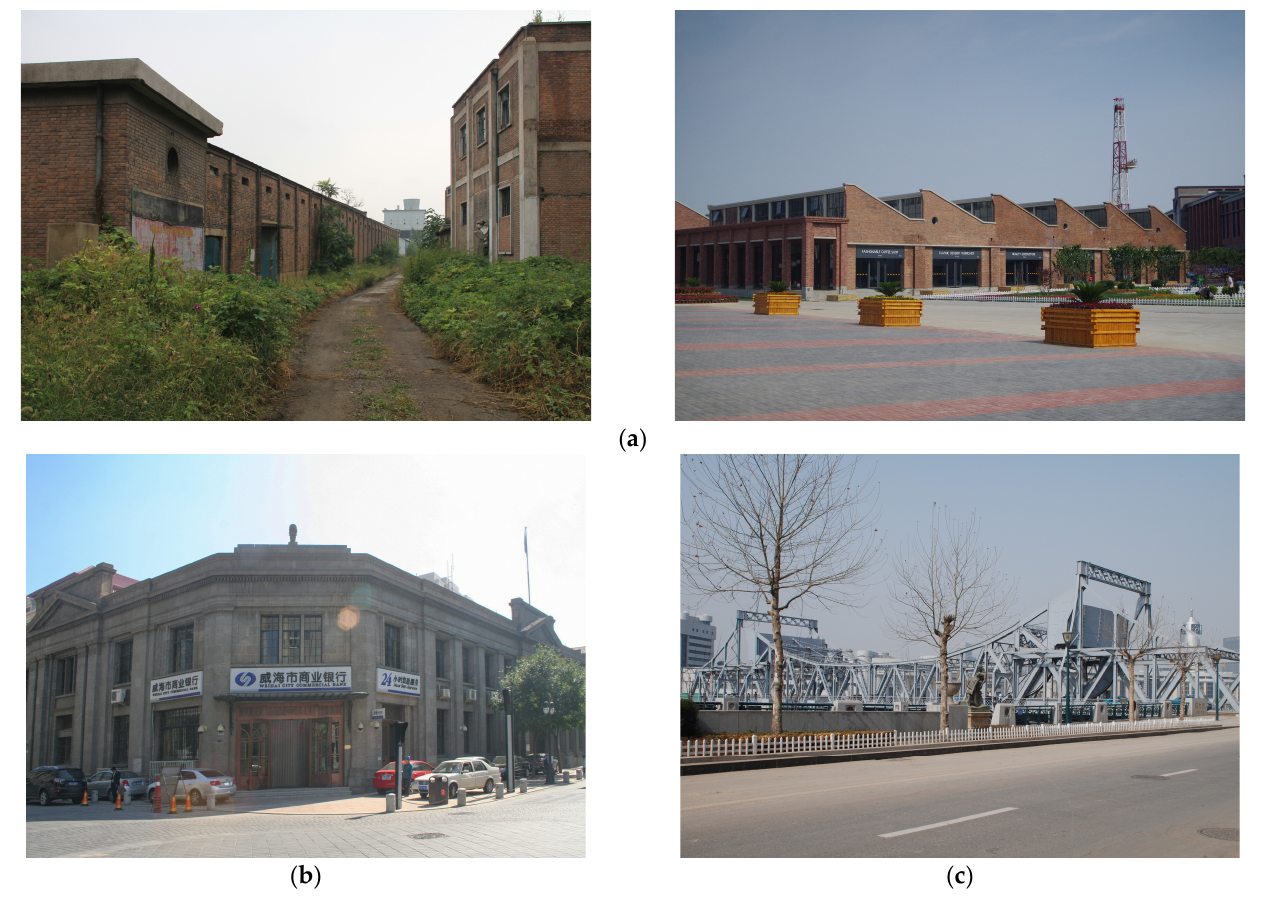
Figure 8. Typical examples of industrial heritage in Tianjin by resource type: ( a ) plant type: Baochengyu Big Yarn Factory before and after renovation; ( b ) building type: the former Jardine Matheson building; ( c ) structure type: Wanguo Bridge.